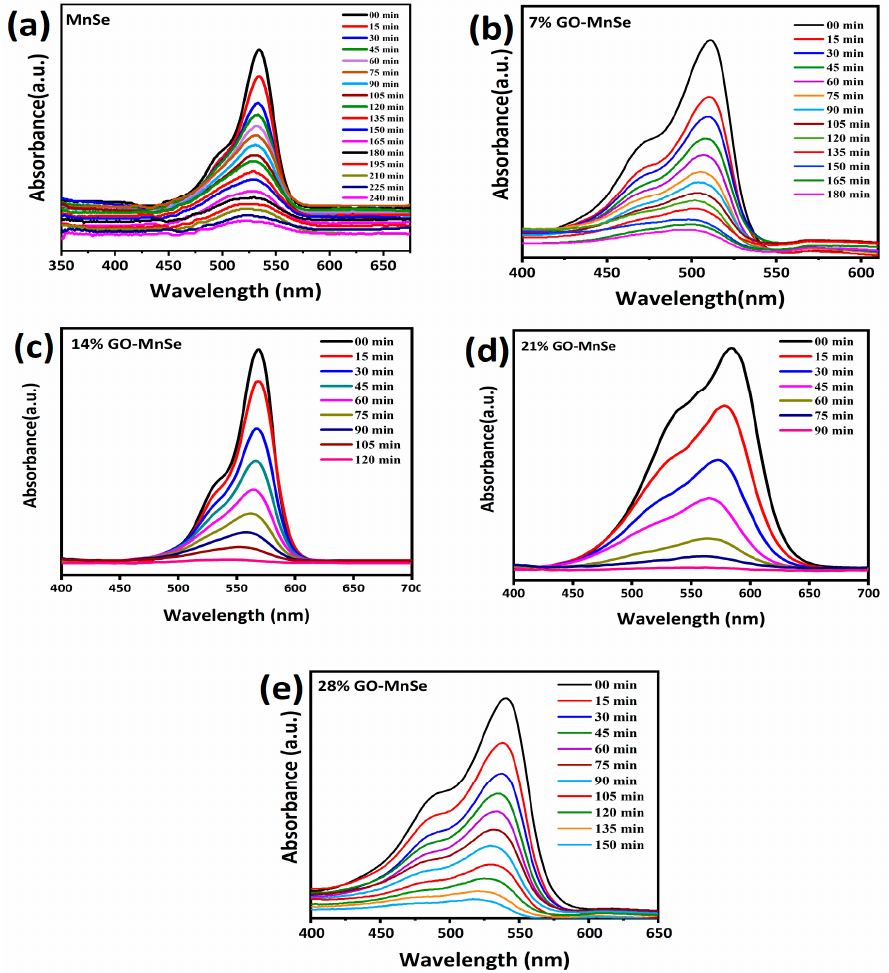
Figure 6. UV-vis spectra of ( a ) MnSe, ( b ) 7% GO-MnSe, ( c ) 14% GO-MnSe, ( d ) 21% GO-MnSe, ( e ) 28% GO-MnSe.